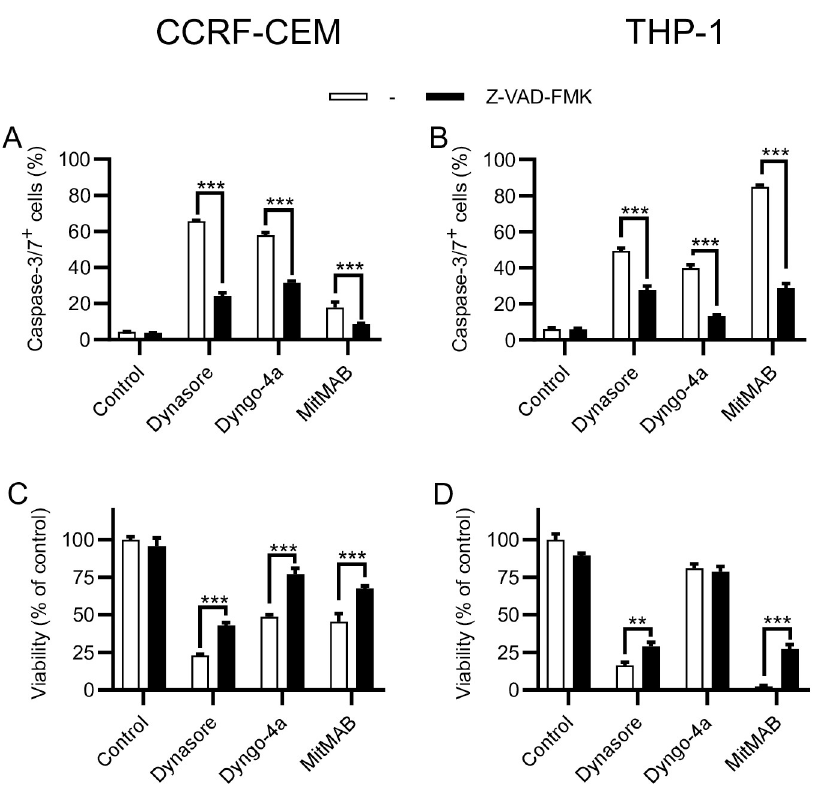
Fig 4. Inhibition of dynamin leads to caspase-3/7-dependent apoptosis in leukemia cells. 0.15 x 10 6 of CCRF-CEM (A, C) or THP-1 (B, D) cells/ml were cultured for 24 h with 40 μ M Dynasore, 10 μ M Dyngo-4a or 3 μ M MitMAB in the absence or presence of 20 μ M Z-VAD-FMK (pan-caspase inhibitor) as indicated. (A-B) Caspase activity was analyzed by flow cytometry after addition of a caspase-3/7 probe. (C-D) Cell viability was assessed with PrestoBlue; treated groups were normalized to control groups. Data are given as mean + SEM, containing 4 pooled replicates from two independent experiments. Two-way ANOVA was used for statistical testing with Sidak’s posthoc test.